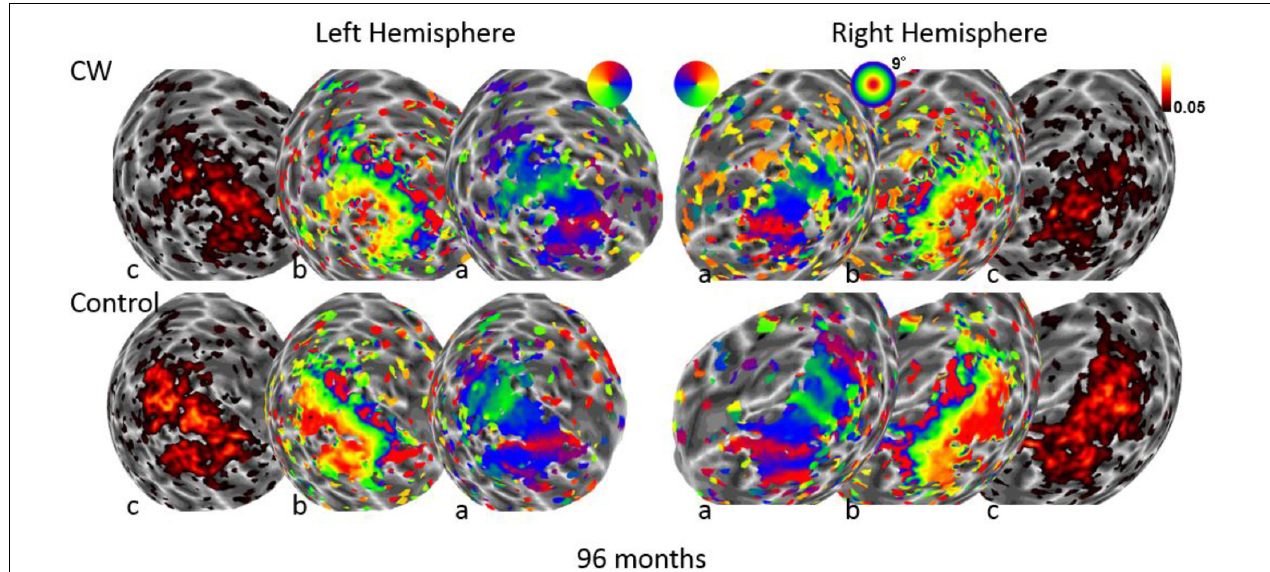
FIGURE 3 | Maps for polar angle (a) , eccentricity (b) , and R2 of model fits (c) on a spherical model of the gray-white matter boundary of the occipital lobe. Maps for CW and one of the control participants are shown from the second retinotopic mapping session at 96 months using a narrow field stimulus (9 ◦ maximal eccentricity). All maps are thresholded at 0.05.